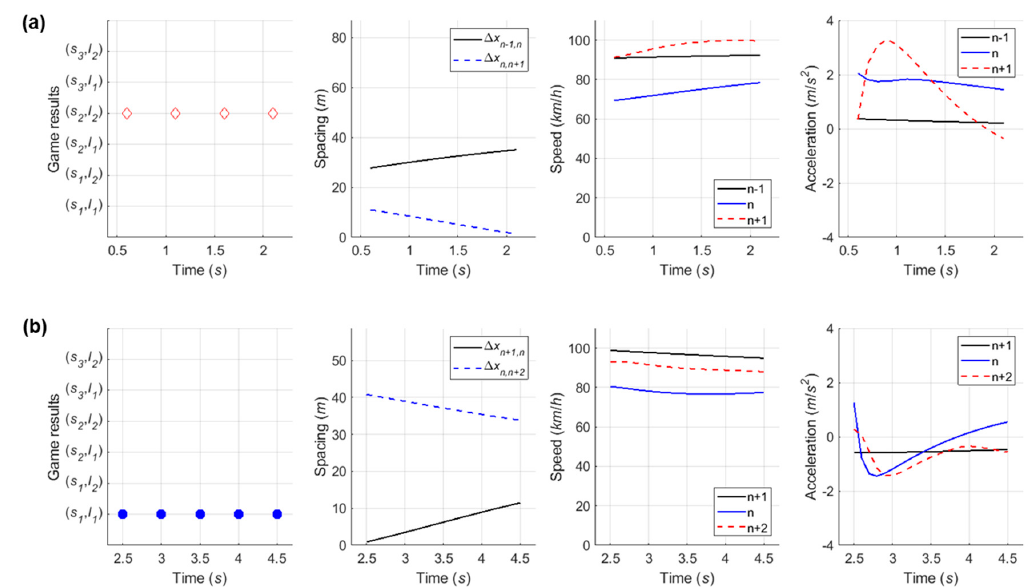
Figure 19. Decision-making game results in case 2: ( a ) Initial game with n + 1; ( b ) additional game with n + 2.